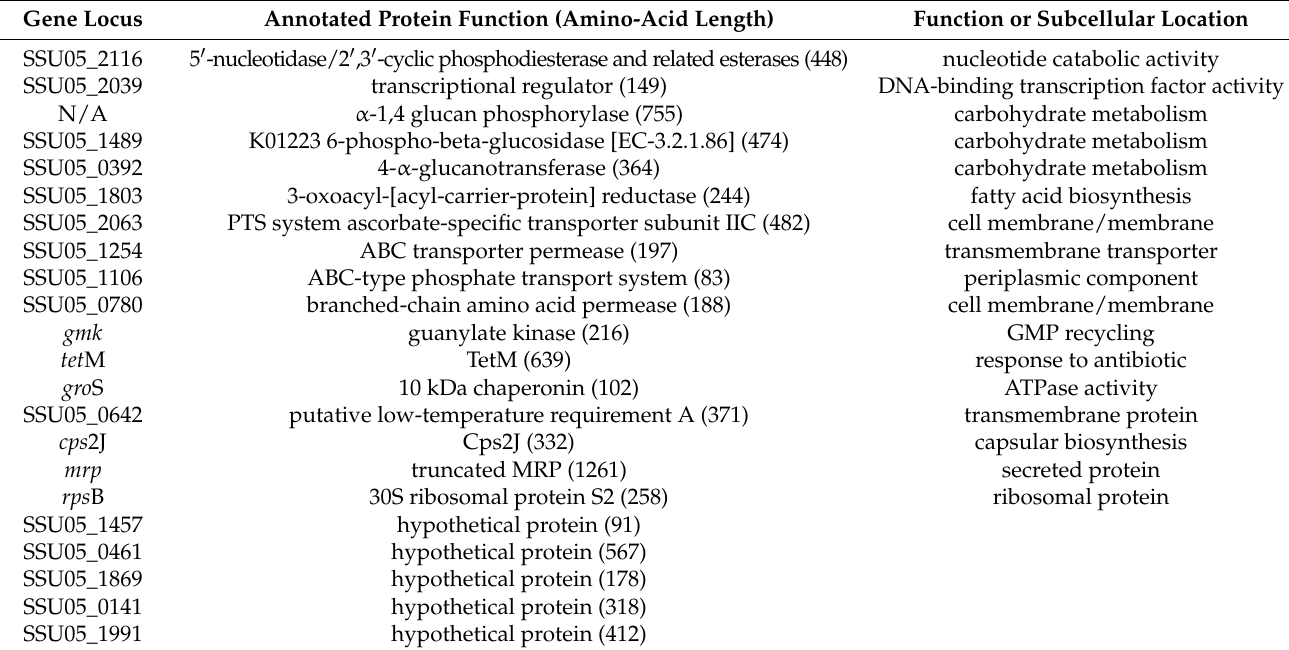
Table 1. Identified peptides derived from S. suis proteins with known function cultured under the host simulated environment. Gene Locus Annotated Protein Function (Amino-Acid Length) Function or Subcellular